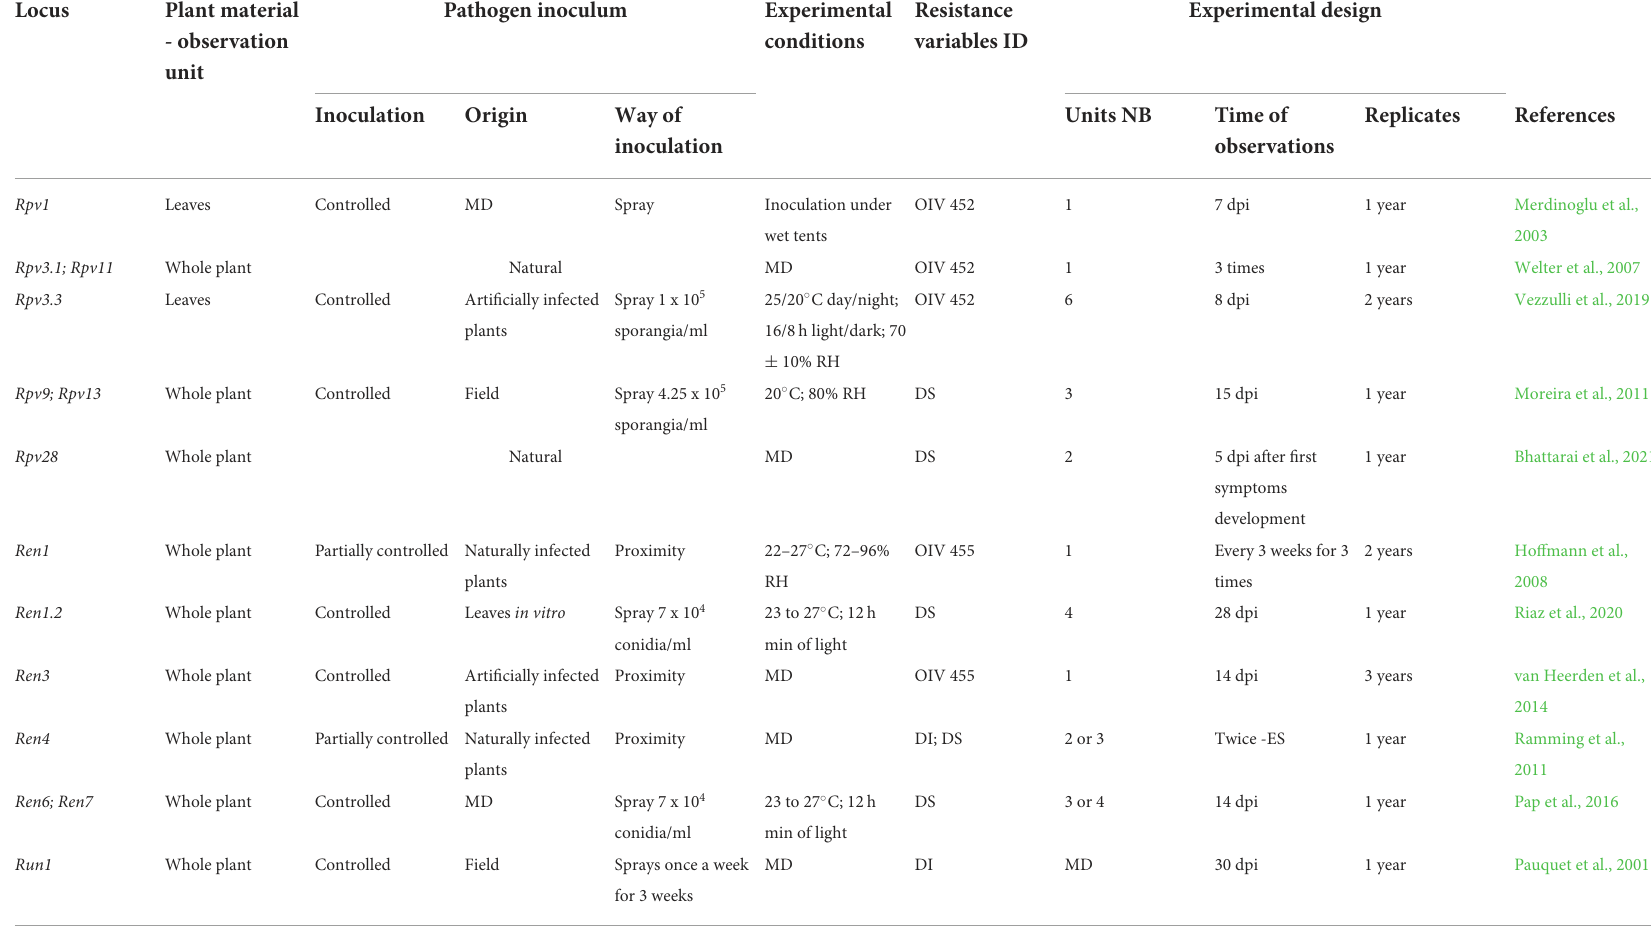
TABLE 5 Resistance phenotyping strategies utilized in the greenhouse. The main elements and possible sources of variation of phenotyping protocols adopted in the main mapping studies are reported for each Rpv and Ren/Run locus.